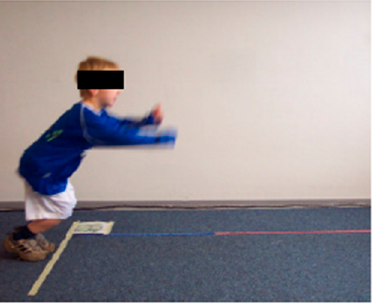
Figure 3. Test setup ‘Standing long jump’, ©Testmanual KiMo-Test; Dr. rer. nat. S. Dordel, Dr. sports